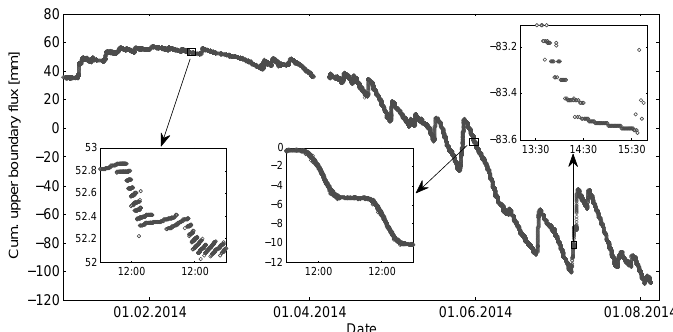
Figure 1. Raw data for the cumulative upper boundary flux of a grass covered lysimeter in Berlin-Marienfelde, Germany. The data of the three selected time intervals on 16–17 February 2014, 30–31 May 2014, and 7 July 2014 between 13:30 and 15:30 are given in the three subplots. Note that the time and flux intervals for the three intervals are different in the